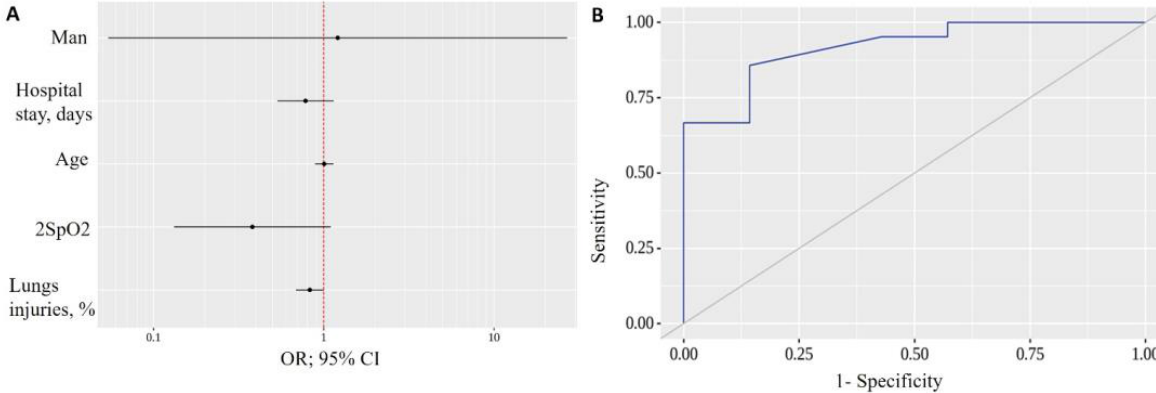
Figure 6. ( A ) Odds ratios estimate with corresponding 95% CIs for predictors included in the IFN- α 2b treatment model; ( B ) ROC curve characterizing the dependence of the IFN- α 2b treatment on value of logistic function P and analysis of the sensitivity and specificity of IFN- α 2b treatment depending on the value p of the logistic function.